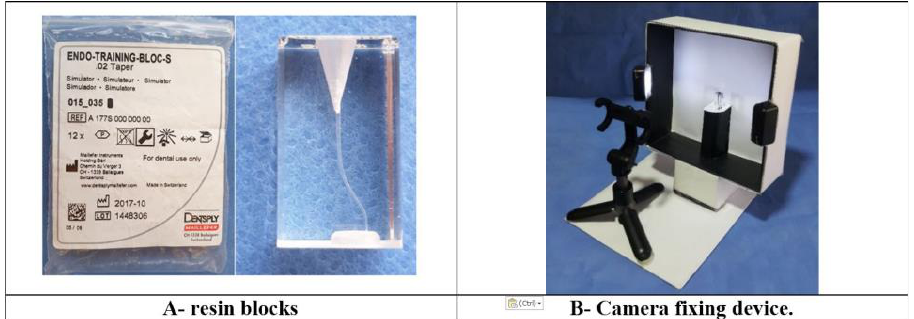
Figure 1: (A) The stimulated resin canals, (B) photo fixing